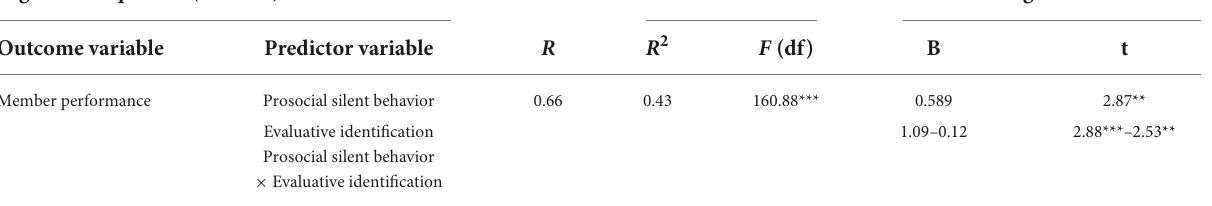
TABLE 7 The moderating effect of online community